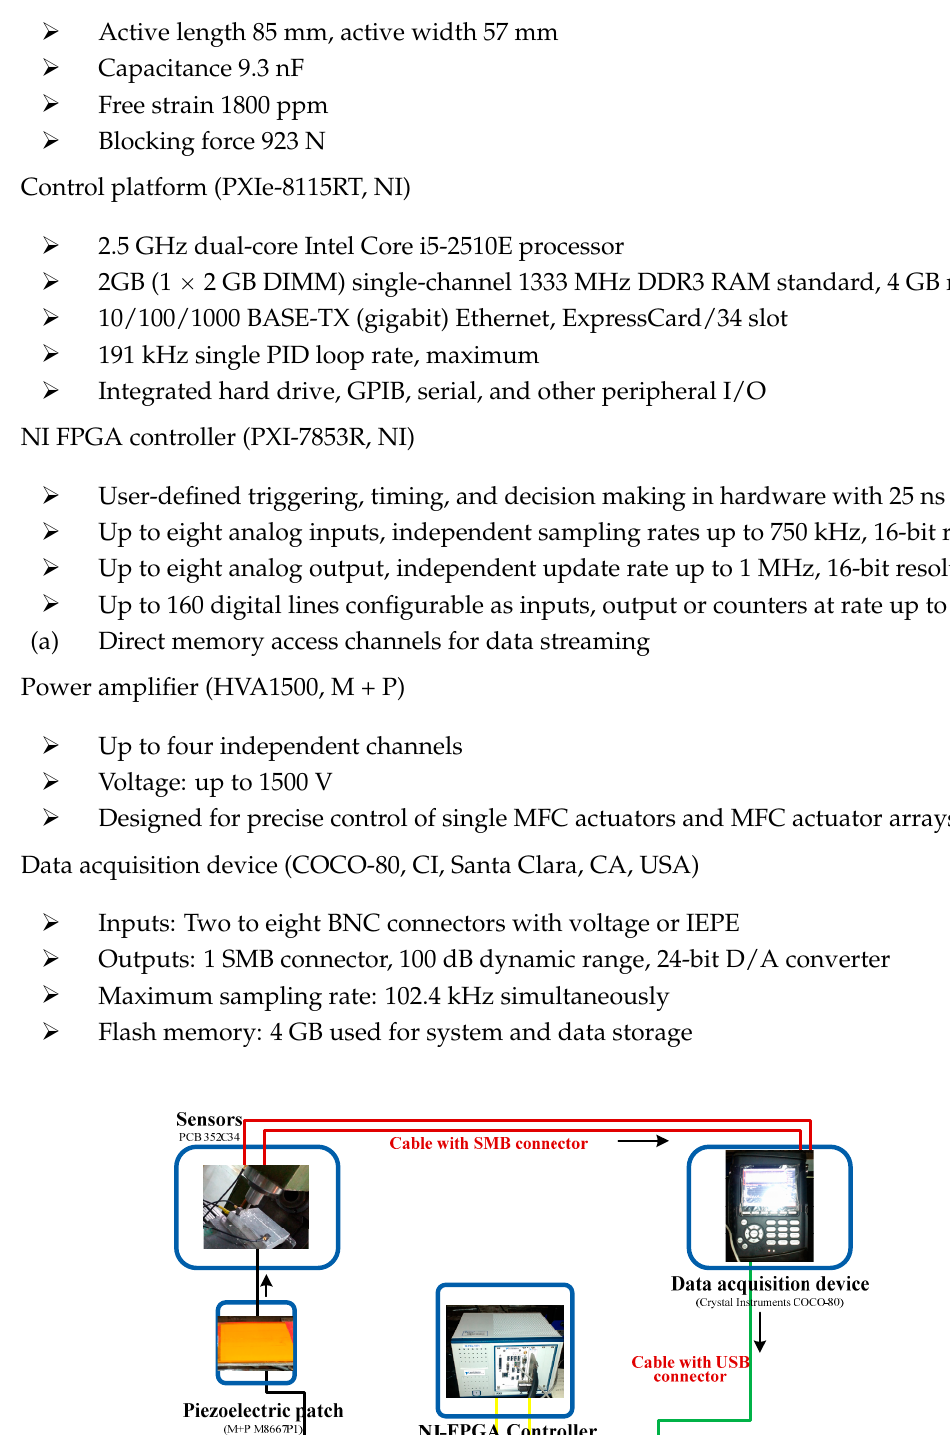
Figure 8. Set-up of the milling process experimental system.